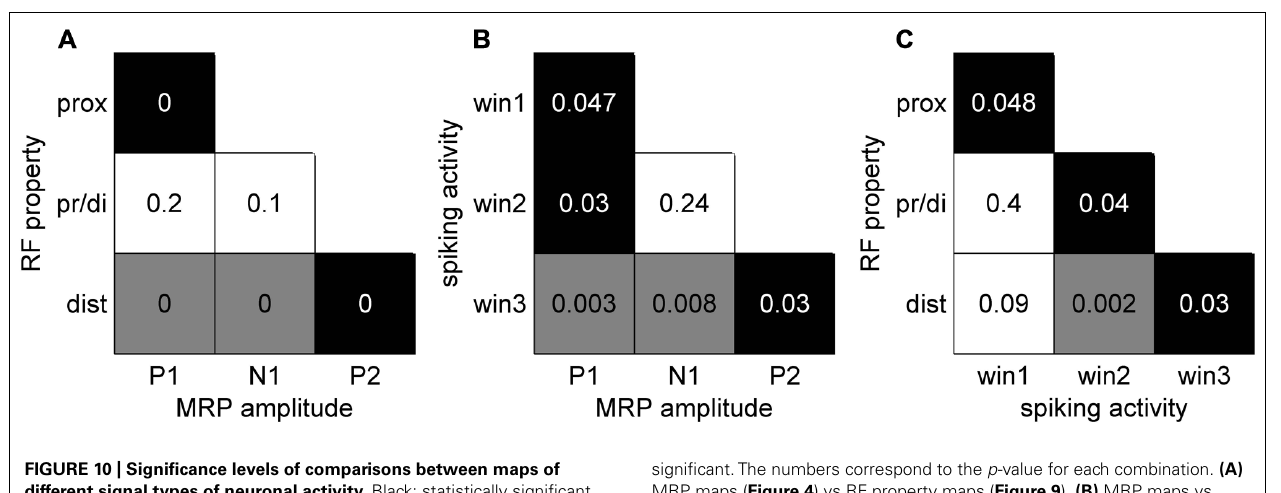
FIGURE 10 | Significance levels of comparisons between maps of different signal types of neuronal activity. Black: statistically significant ( p < 0.05) positive map; gray: statistically significant negative map; white: not